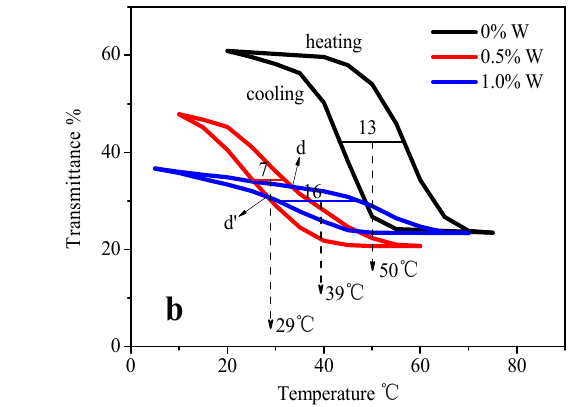
ture (T c ) of 0.5%W-doped VO 2 thin film is significantly decreased (T c = 29 ◦ C). However, the NIRSE remains high (27%), and the shape of the thermal hysteresis loop is not distorted seriously. With the increase in the concentration of W dopant to 1% (i.e., 1.0%W-doped VO 2 film), the phase transition temperature does not decline continuously but rises, especially above the temperature T d or T (33 ◦ C or 28 ◦ C), due to which the average T c decreases d (cid:48) to 39 ◦ C. In addition, the NIRSE is negatively affected and reduces to 13%. At the same time, the shape of the thermal hysteresis loop is seriously distorted: the height decreases (13%, while for 0.5%W: 27%), the gradient becomes more gentle, and the width increases considerably (16 ◦ C, while for 0.5%W: 7 ◦ C).